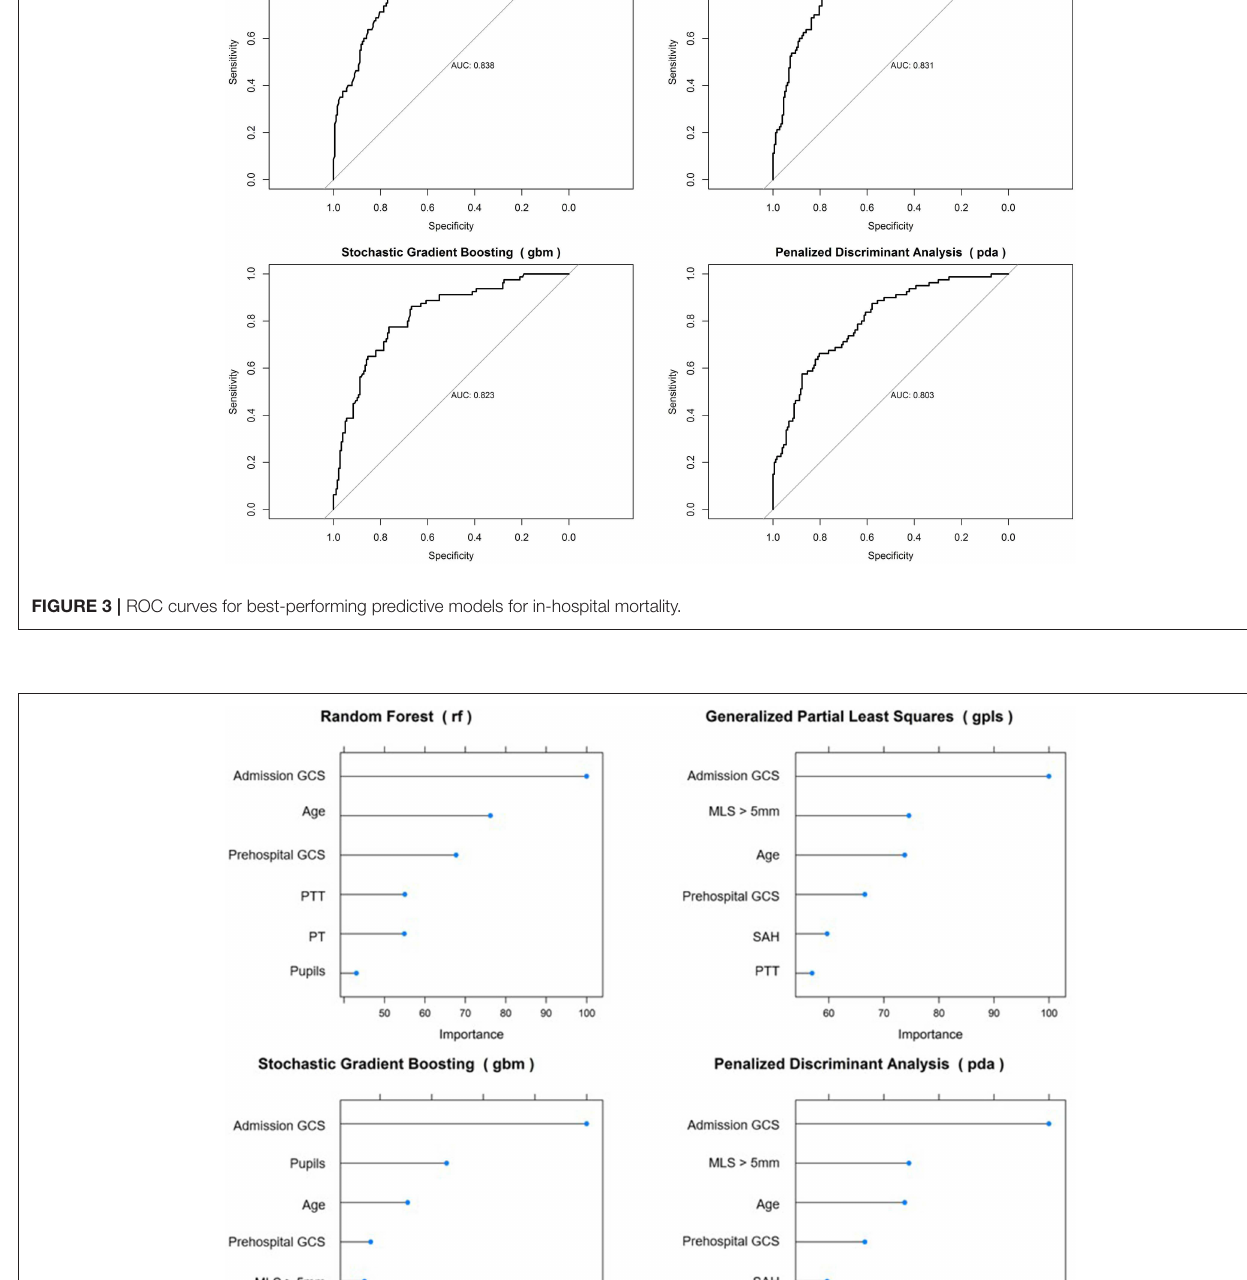
Frontiers in Neurology | www.frontiersin.org